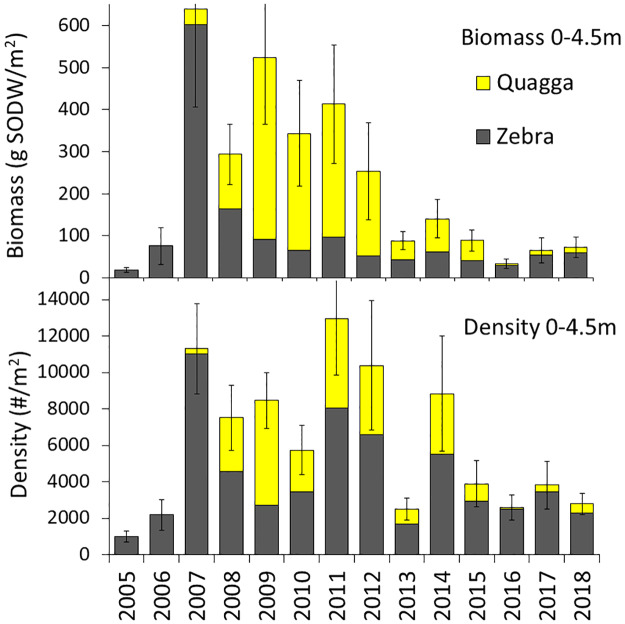
Development of the zebra and quagga mussel populations (biomass and density) in Onondaga Lake from 2005 to 2018.Depths 0–4.5 m were included. SODW is shell-on dry weight. Values are arithmetic means of site values. Bars represent ± 1 SE calculated using site averages of the sum of both species.